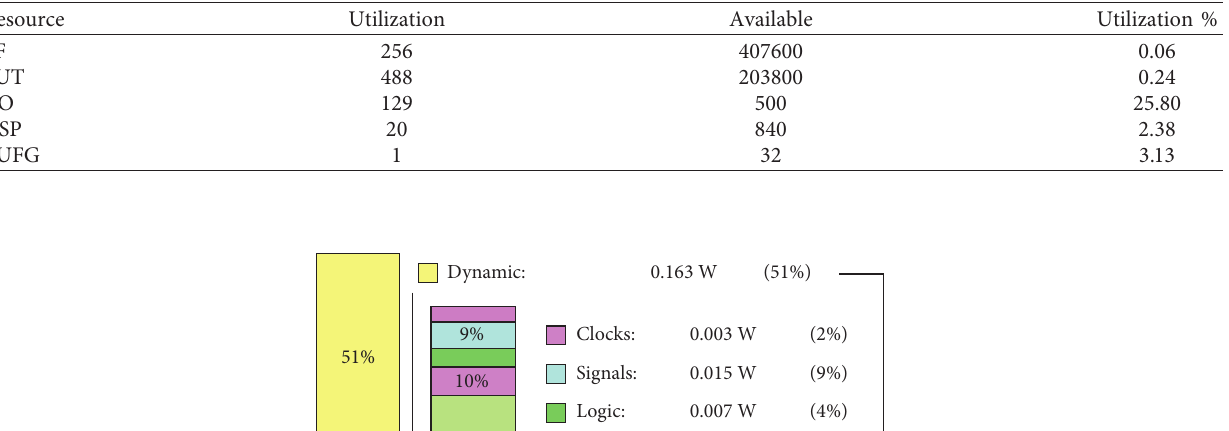
Figure 19: Power consumed for the FPGA implementation of memristive hyperjerk chaotic system (1). Table 2: Resource utilization for the FPGA implementation of memristive hyperjerk chaotic system.